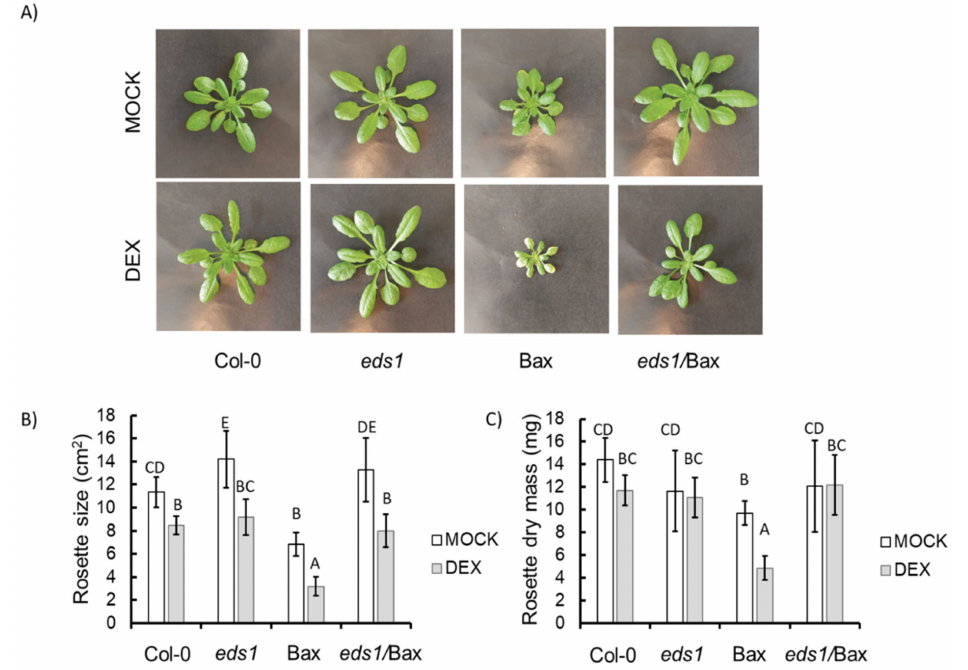
Figure 1. Plant phenotype ( A ), rosette size ( B ), and biomass ( C ) in the wildtype, ENHANCED DISEASE SUSCEPTIBILITY 1 ( eds1 ) mutants, and Bax and eds1 / Bax lines ( + mock /+ DEX (dexamethasone)): within a subgraph, values sharing common labels (letters) are not significantly di ff erent from each other ( p > 0.001) ( n = 8–12).